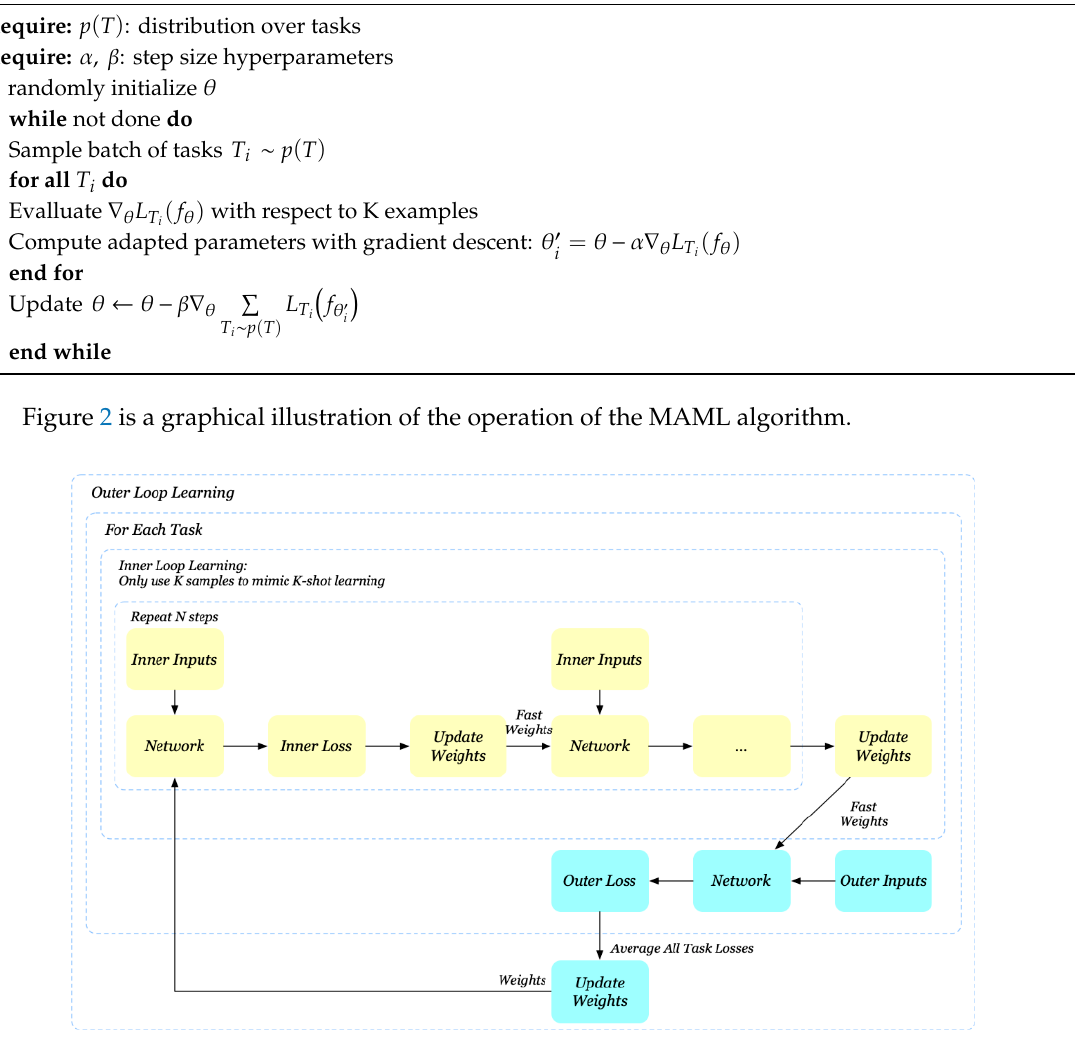
Algorithm 1. MAML.